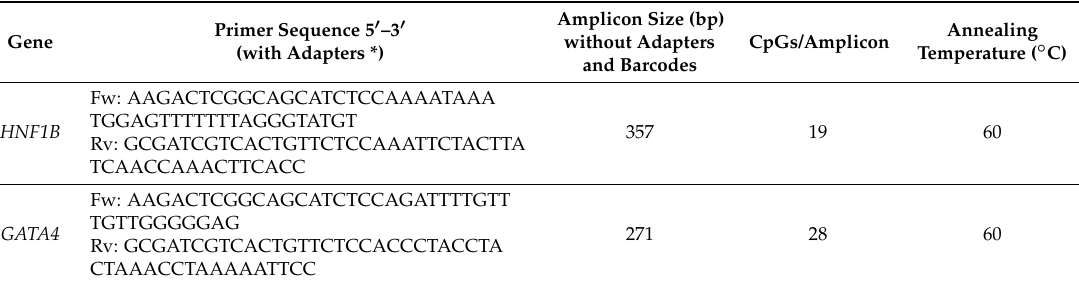
Table 3. NGS primer sequences and amplicons